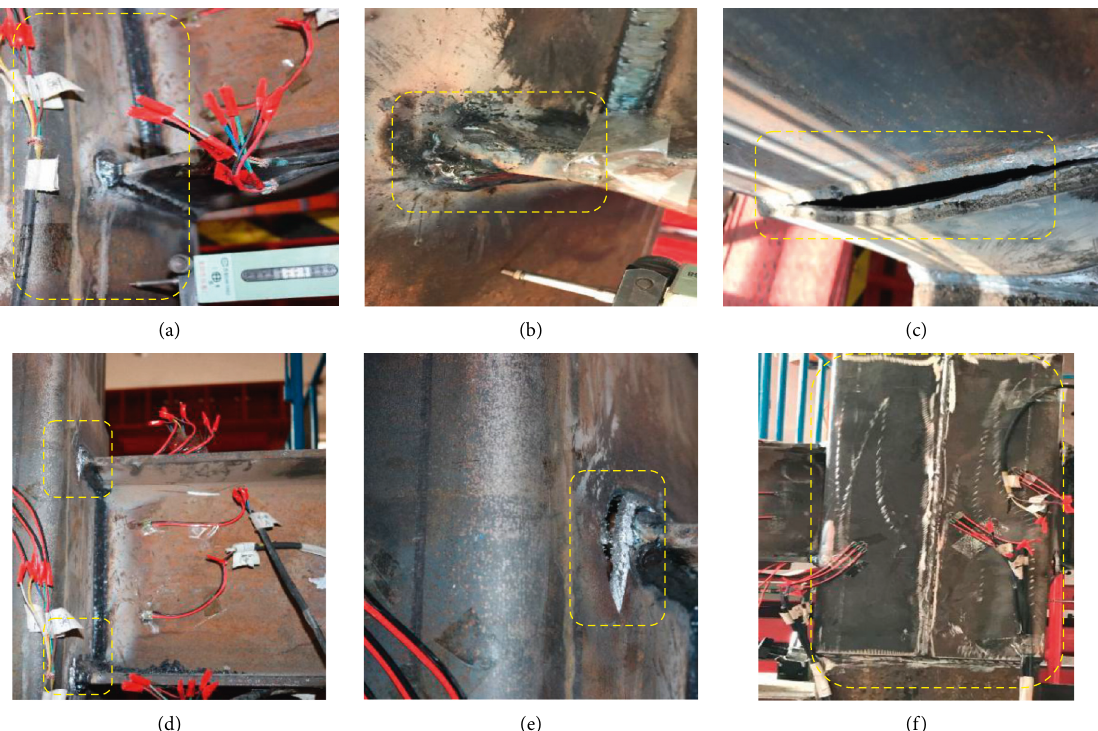
Figure 6: Failure modes of specimens. (a) Sleeve local buckling; (b) base metal tearing of the left; (c) weld cracking; (d) base metal tearing of upper; (e) sleeve tearing; (f) joint failure.